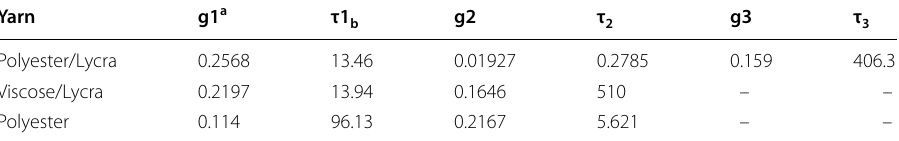
a gi: Prony Constant b τ i : Relaxation Time